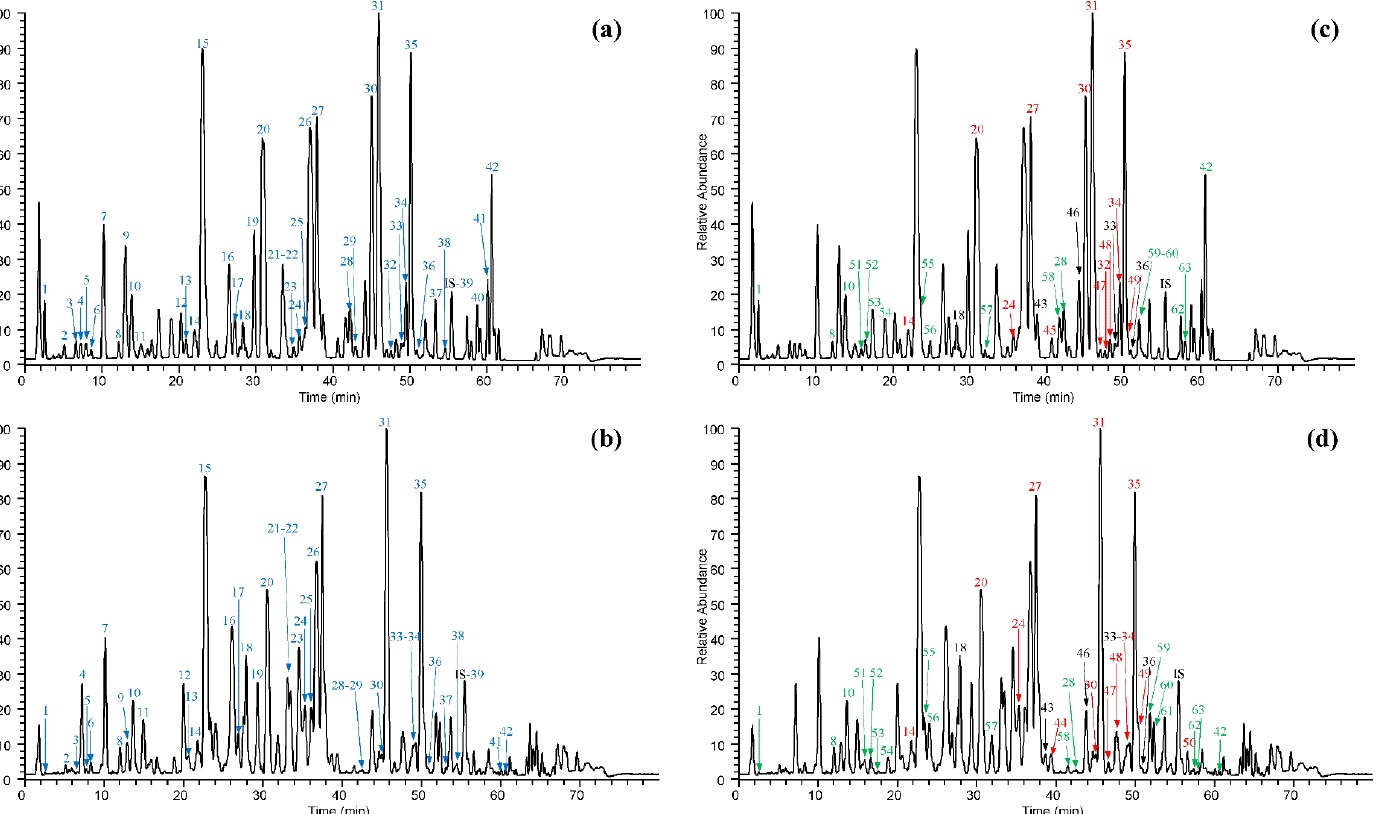
Figure 1. Total ion currents (TICs) of BFPF and BLPF extracts. In panels ( a ) and ( b ) the ions identified by the targeted approach are labelled in blue with a progressive number. In panels ( c ) and ( d ) the ions identified with the semi-targeted and untargeted approaches are labeled in red and green, respectively. (IS) Internal standard (Trolox); BFPF: panels ( a ) and ( c ); BLPF panels ( b ) and ( d ).